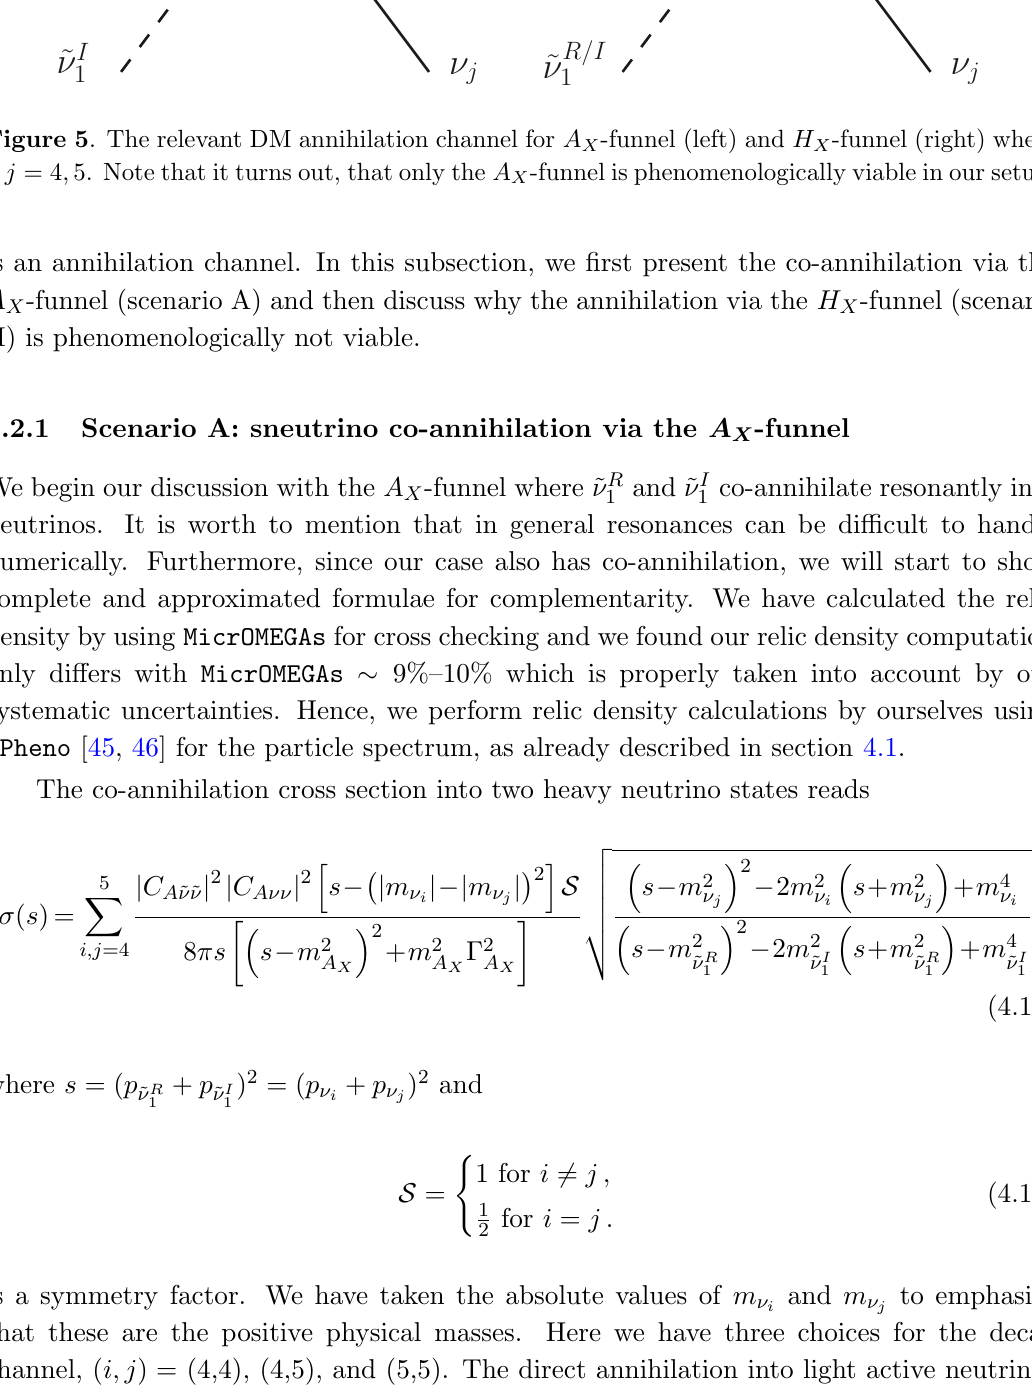
Figure 5 . The relevant DM annihilation channel for A X -funnel (left) and H X -funnel (right) where i; j = 4 ; 5. Note that it turns out, that only the A X -funnel is phenomenologically viable in our setup.